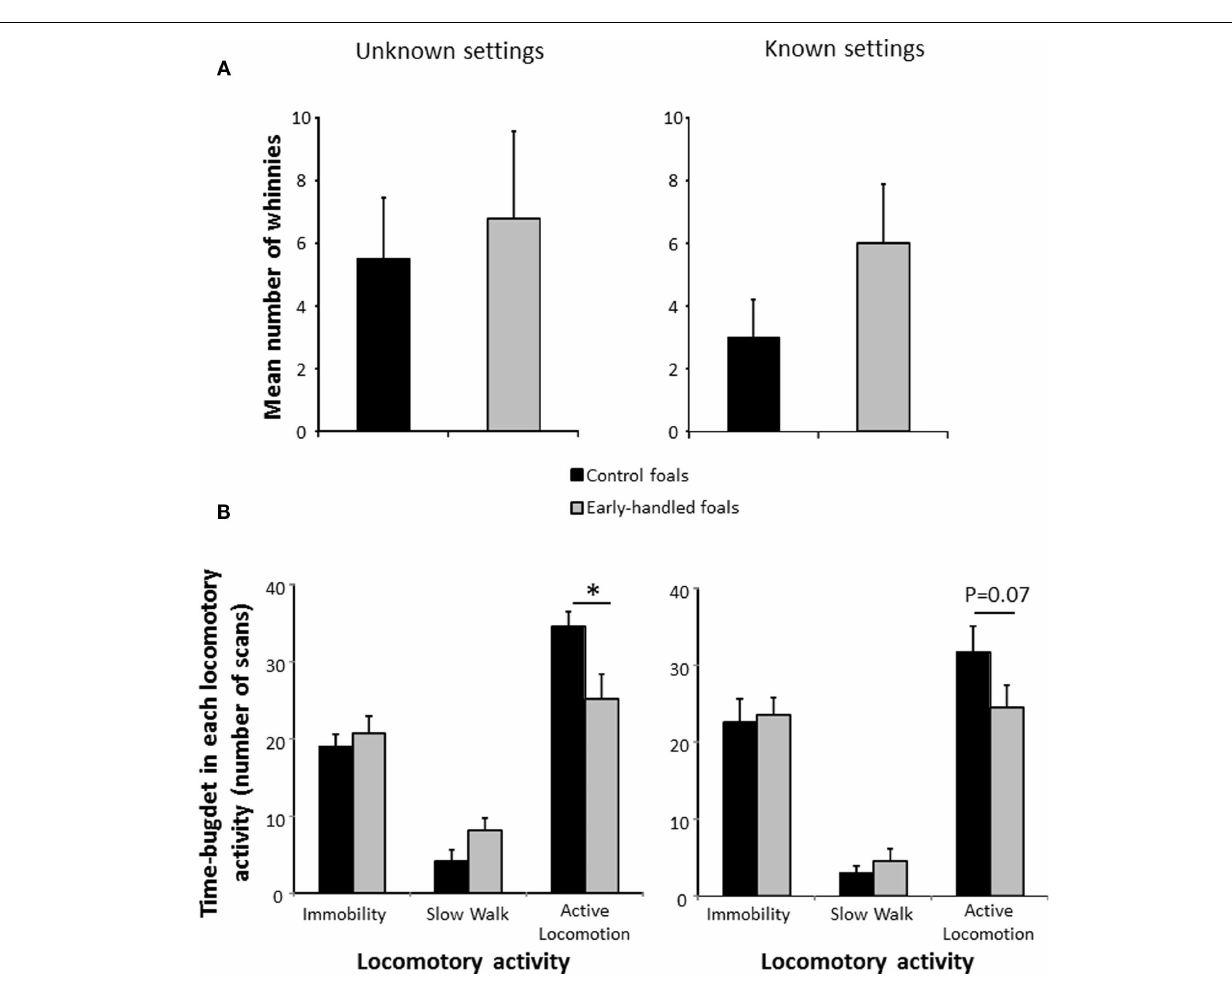
FIGURE 3 | Behaviors of 2-year-old, early handled, and unhandled foals during social separation. (A) : mean number ( ± SEM) of whinnies emitted during the experiments; (B) : mean number ( ± SEM) of scans when the foals performed different types of locomotor activity. Unknown settings (on the left): foals left alone in an unknown arena; Known settings (on the right): foals left alone in the same arena on the following day, the arena is now more familiar.